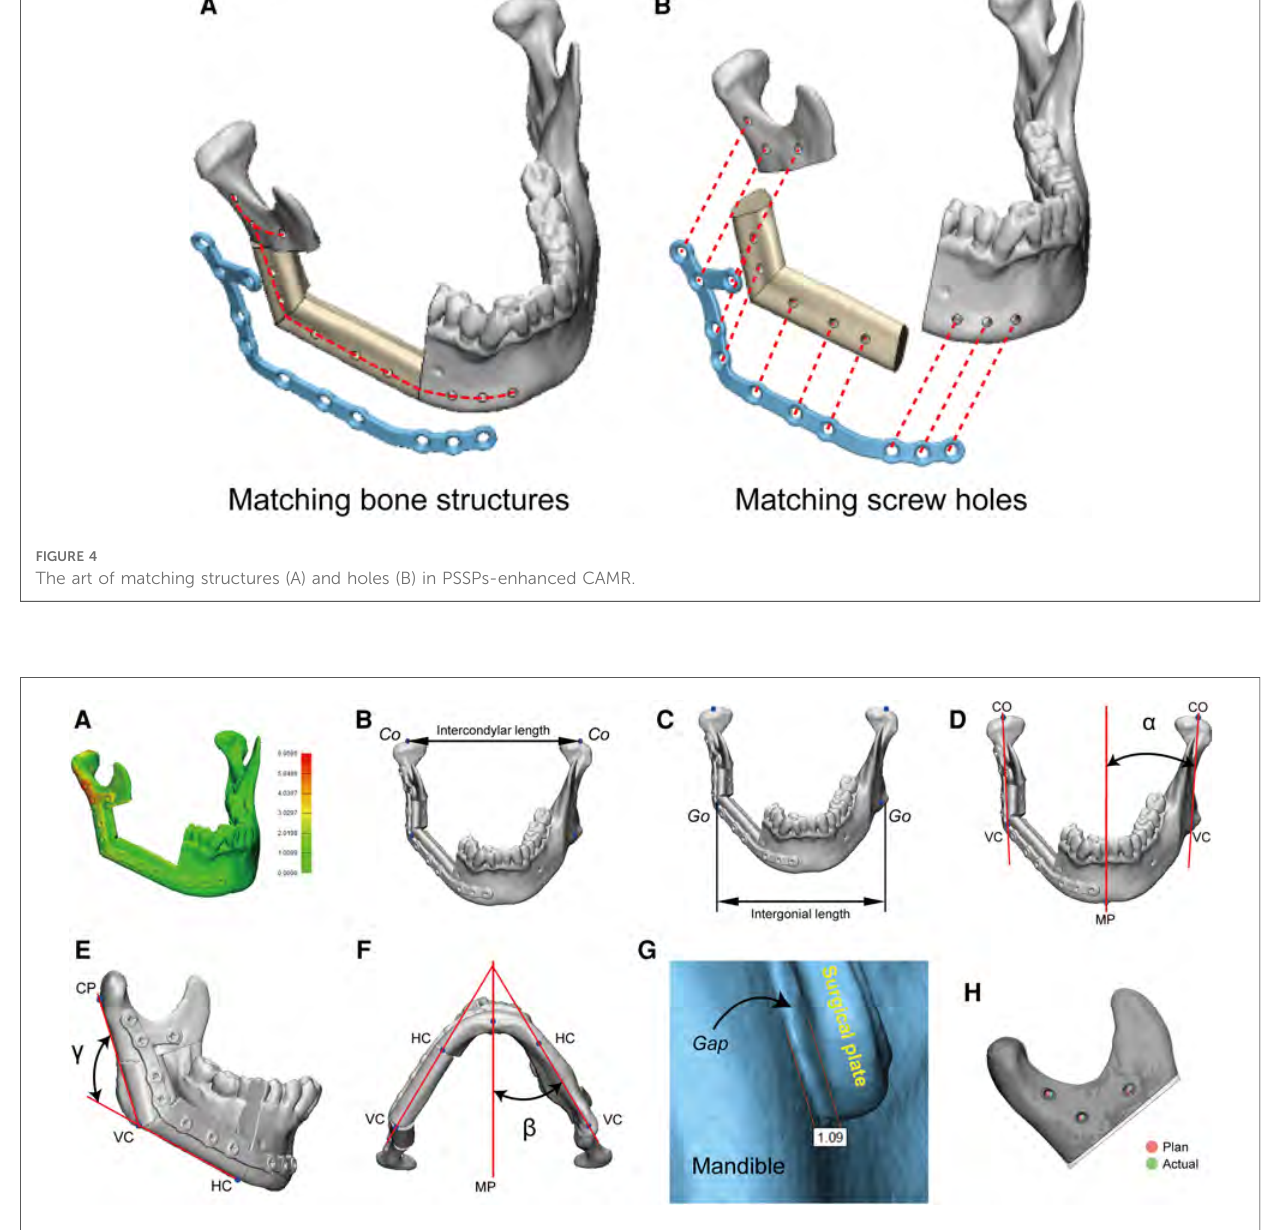
(4) Coronal mandibular angle ( Figure 5D ): the angular difference between the preoperative and postoperative coronal mandibular angles.